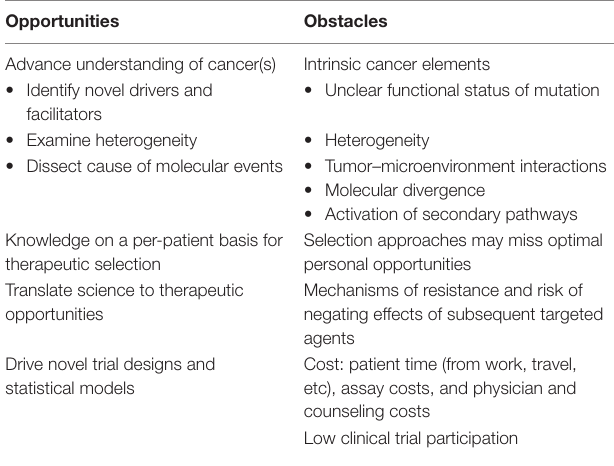
TABLe 1 | Obstacles and opportunities of molecular testing in gynecologic